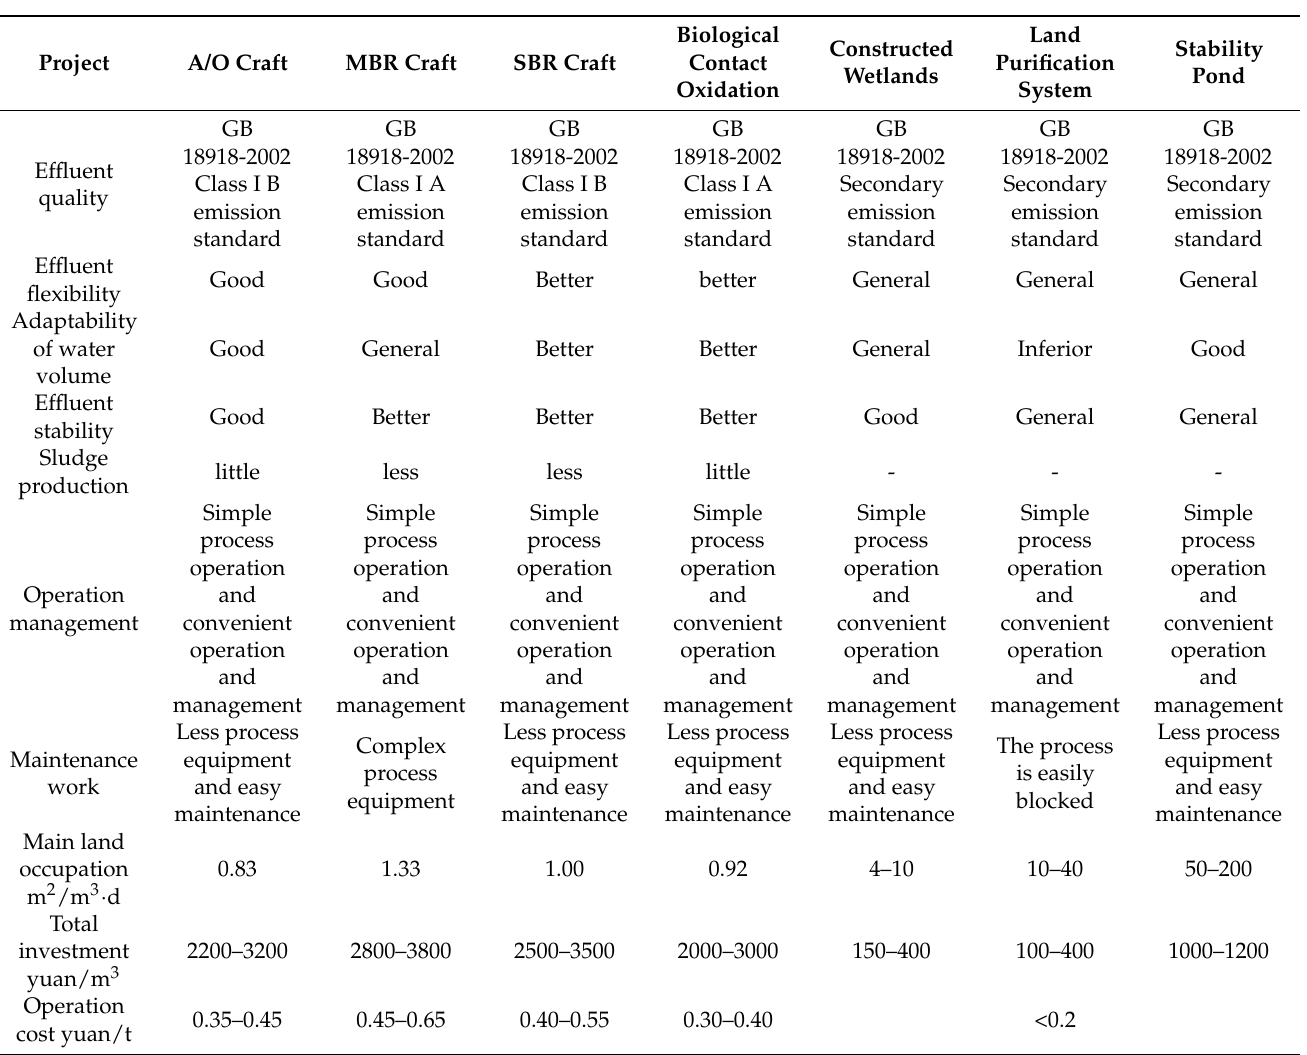
Table 2. Comparison of common technological and economic